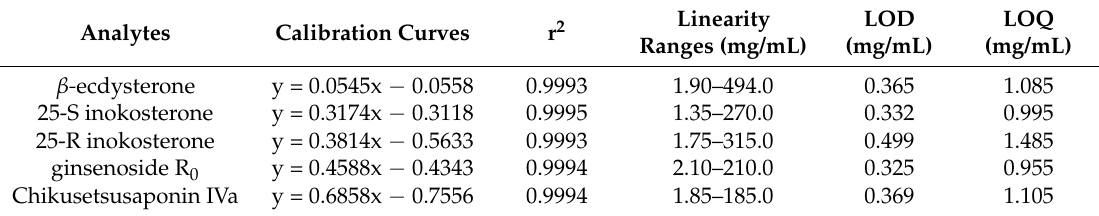
Table 2. Calibration curves, correlation coefficients, linearity ranges, limit of detection (LOD) and limit of quantity (LOQ) data of the five investigated analytes.